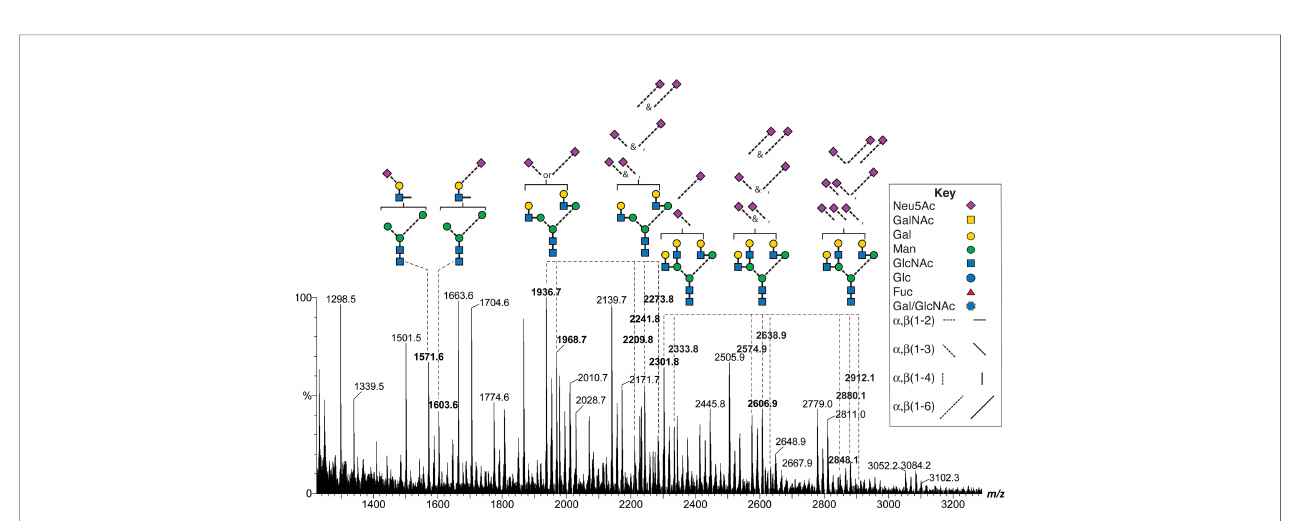
FIGURE 8 | MALDI-MS analysis of DMT-MM-derivatized hFSH a Asn 52 oligosaccharides. Representative mono-, di-, and tri-antennary glycans showing patterns of a 2-3 and a 2-6 linked Neu5Ac residues for the mono-, di- and tri-sialylated variants of the neutral glycan structures. The m/z values for selected oligosaccharide ions are shown in